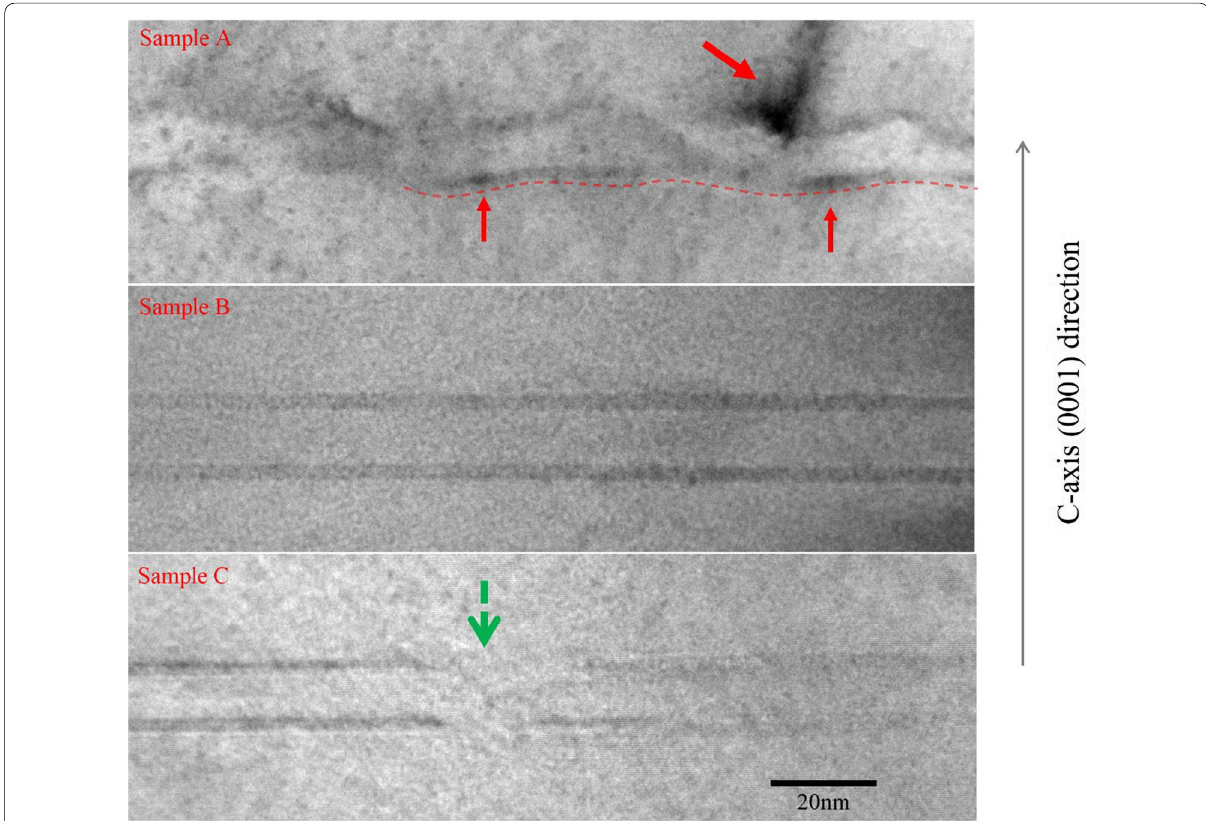
Fig. 2 The cross section TEM images of samples A, B and C. In the image of sample A, the red dashed line marks the undulated MQWs interface and the red arrows point out the indium-rich clusters in MQWs. In the image of sample C, the green arrow points out the damaged part interfaces of